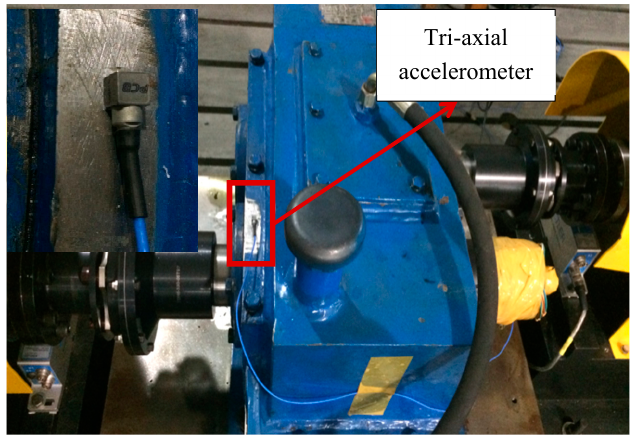
Figure 8. Vibration and torque measurement for the testing gearbox. Table 2. Operation condition of the experiments.